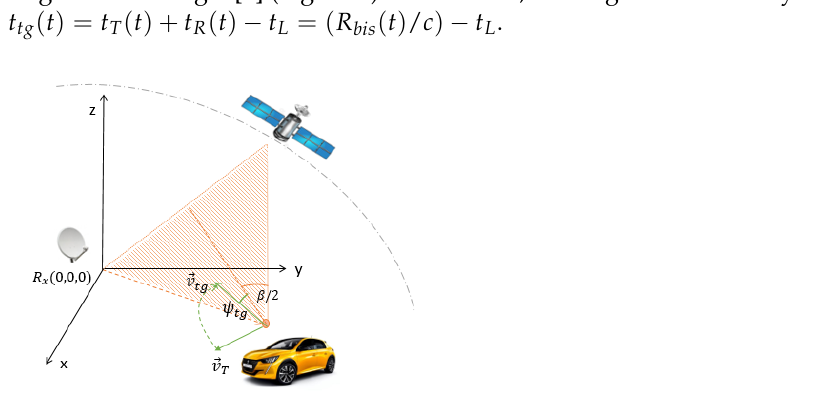
Figure 3. Projections on the passive radar, illuminator of opportunity, and target